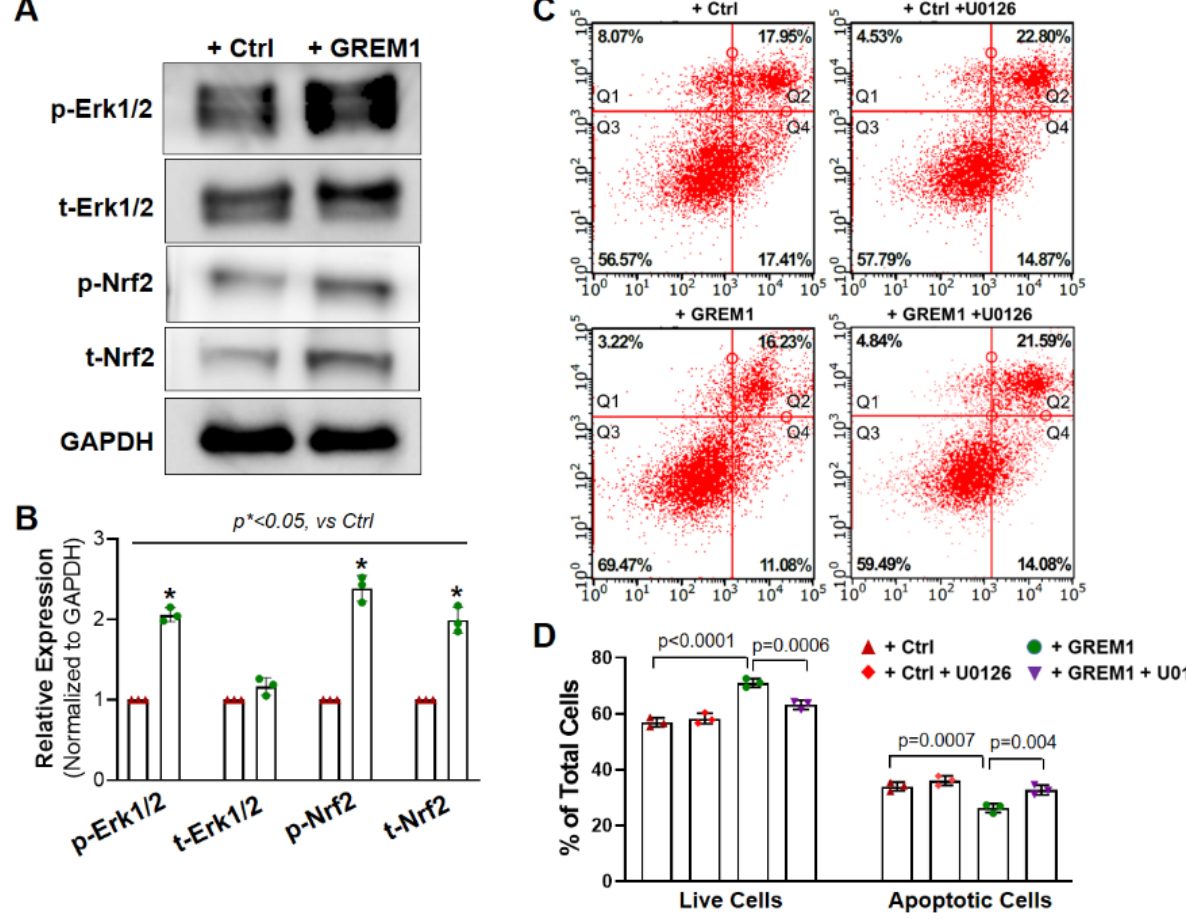
Figure 5. Activation of NRF2/ERK signal pathway is associated with the cytoprotective effect of overexpressing GREM1. ( A ) Representative image of Western blots showing increased protein expression of total and phosphorylated ERK1/2 and NRF2 in hMPCs with GREM1 overexpression. ( B ) Quantitative analysis of panel A. ( C ) FACS analysis with annexin V/PI double staining shows that specific inhibition of ERK activity by U0126 diminishes the cytoprotective effect of overexpressing GREM1 in aged hMPCs, as indicated by the decreased number of live cells (Q3) and increased number of apoptotic cells (Q2 + Q4) compared with cells without U0126 treatment as control. ( D ) Quantitative analysis of the FACS assay shown in C. Data are mean ± SEM. p value was calculated by unpaired Students’ t -test, n = 3 independent experiments. * indicated the signi fi cant di ff erence com- pared to the control group.